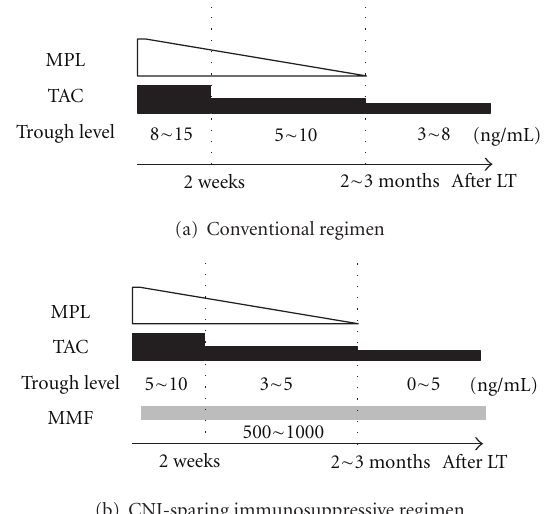
Figure 1: Immunosuppressive protocol after liver transplanta- tion. The basic immunosuppressive regimen comprised tacrolimus (TAC) and methylprednisolone (MPL), with doses gradually being tapered o ff . The trough whole blood levels of TAC were maintained between 8 and 15ng/mL in the first few postoperative weeks and between 5 and 10ng/mL thereafter (a). Renal insu ffi ciency (RI) group received CNI-sparing immunosuppressive regimen (CSR) consisting of TAC reduction and concomitant use of mycophenolat mofetil (MMF)